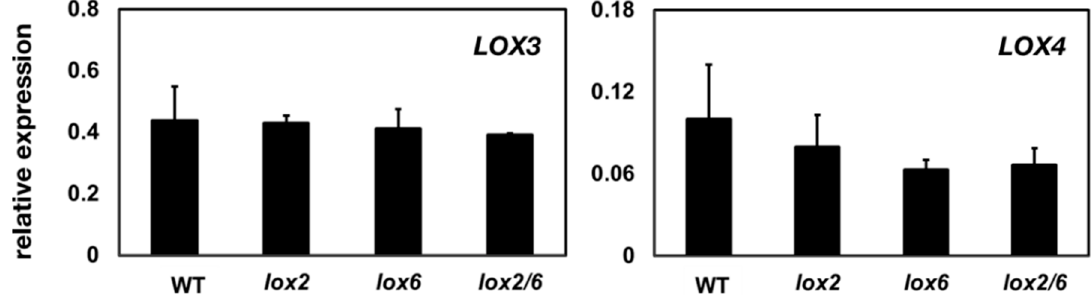
Figure A2. Basal LOX3 and LOX4 expression is not affected in the lox2 and lox6 backgrounds. Samples were from leaf 8 of five-week-old plants. LOX3 and LOX4 transcript levels are relative to those of UBC21 .